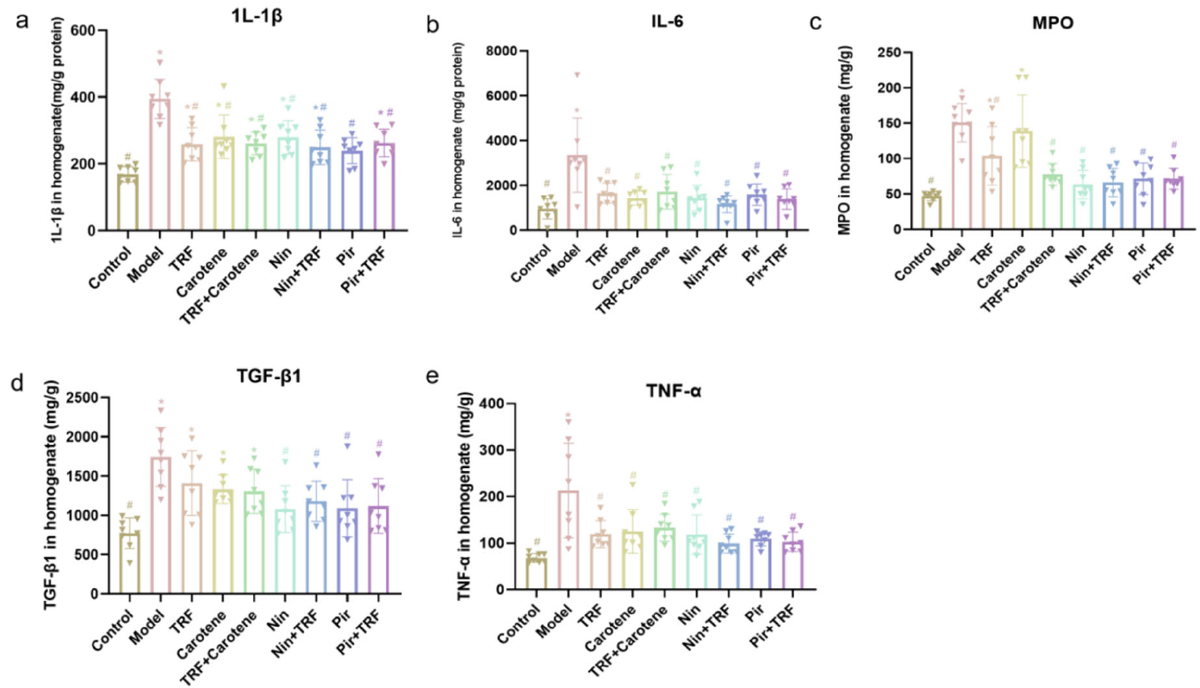
Figure 3. Effects on proinflammatory cytokine levels of TRF in the lung tissues of BLM ‐ induced lung fibrosis ( a – e ); n = 8. Note: * represents p < 0.05 in comparison to the control group; # represents p < 0.05 in comparison to the model group.